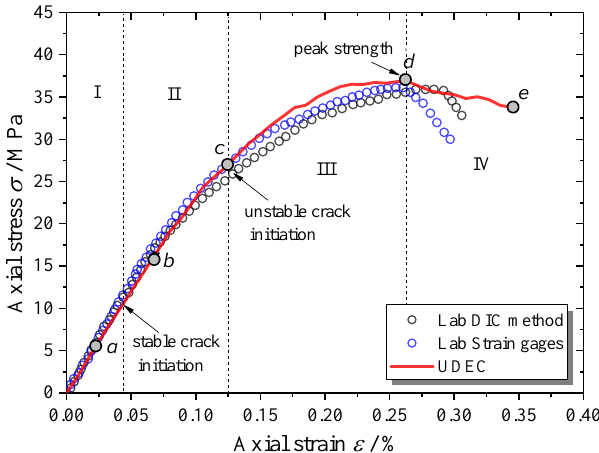
Figure 10. Complete compressive stress–strain curves of MRAC specimen.